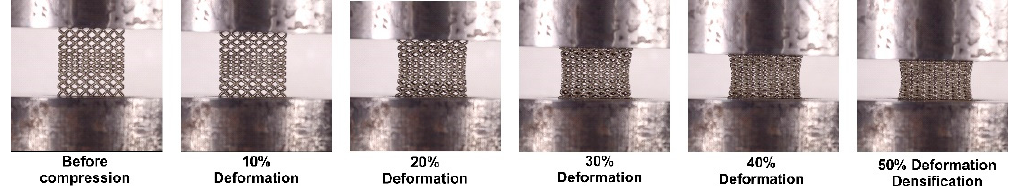
Figure 12. The main stages of the deformation process of a lattice specimen with a regular topology.